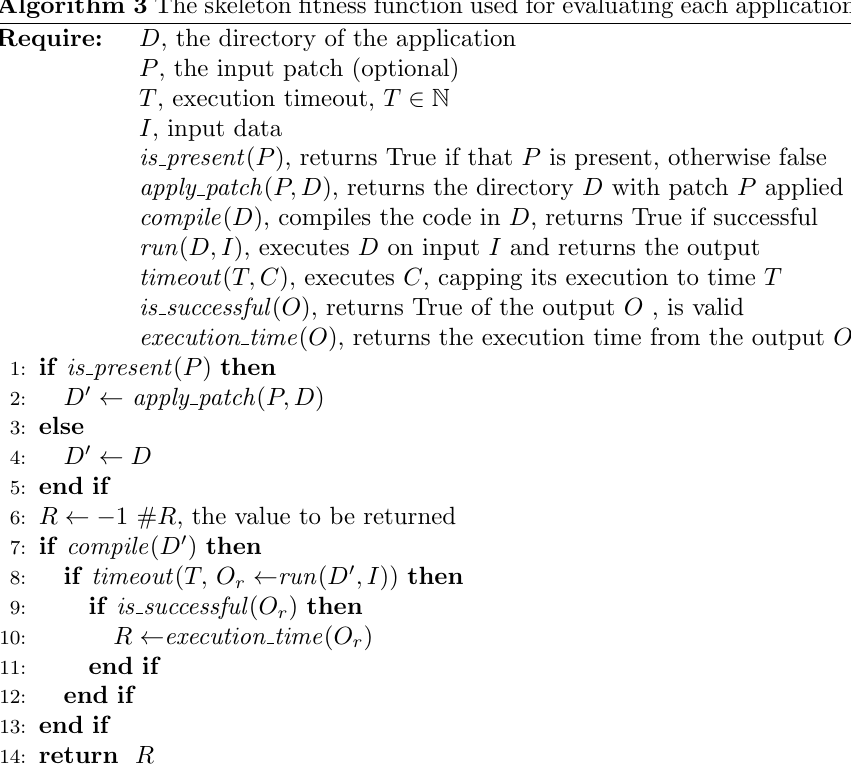
Algorithm 3 The skeleton fitness function used for evaluating each